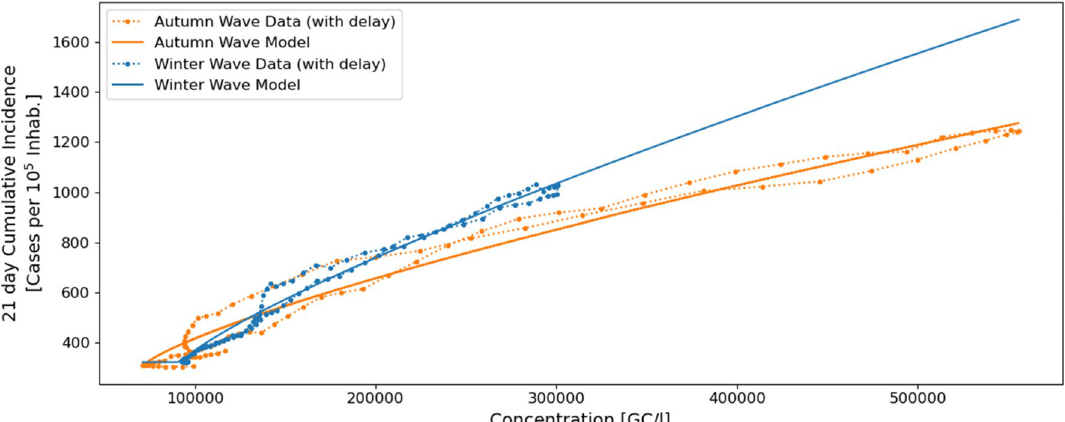
Figure 6. Fitting functions of the wave model for the global population-averaged dataset corresponding to the autumn (orange) winter (blue) waves. The dotted lines show the smoothed concentration-incidence relationship after applying the optimal delay, and the solid lines show the adjusted